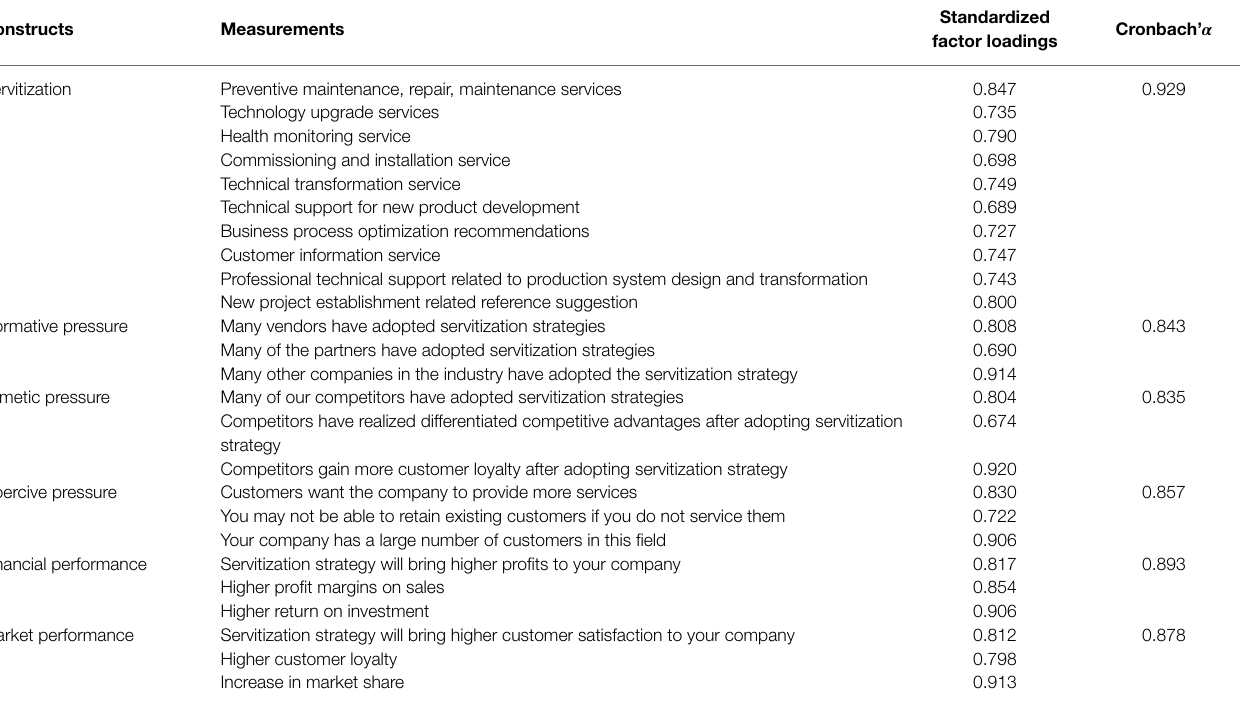
TABLE 3 | Construct measurement and confirmatory factor analysis results.